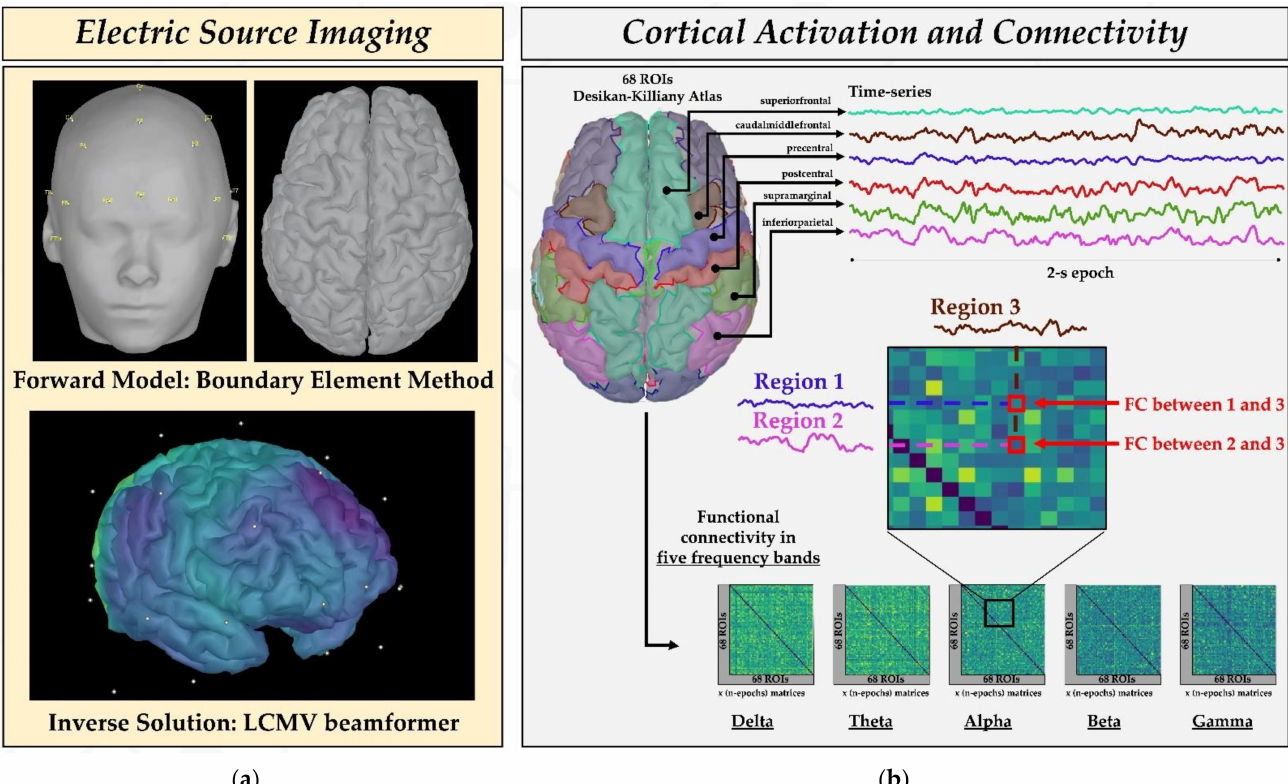
Figure 2. Source connectivity analysis. ( a ) To estimate the cortical activity from EEG data, we performed electric source imaging (ESI). A 3-layer boundary element method (BEM) was applied to solve the forward problem (i.e., compute the head model) after extracting the 3D head mask and cortical surface ( top left ) from each patient’s MRI. Electrodes were positioned on the head based on the 10–20 system. A linearly constrained minimum variance (LCMV) beamformer was used to solve the inverse problem, which generated a cortical activation map for each 2 s epoch ( bottom left ). ( b ) We estimated the activity of each cortical region of interest (ROI), obtaining a time series for each ROI. Functional connectivity between these regions was estimated for five frequency bands ( δ (2–4 Hz); θ (5–7 Hz); α (8–12 Hz); β (13–29 Hz); γ (30–70 Hz)). Each element of the connectivity matrix indicates how much an ROI is connected to another in that 2 s